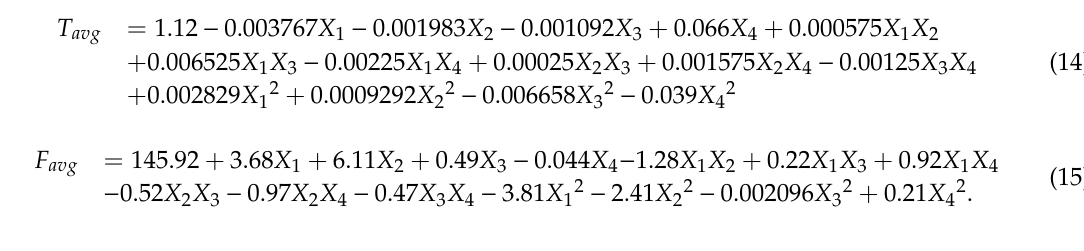
Table 3. Machine fixed structure parameters.